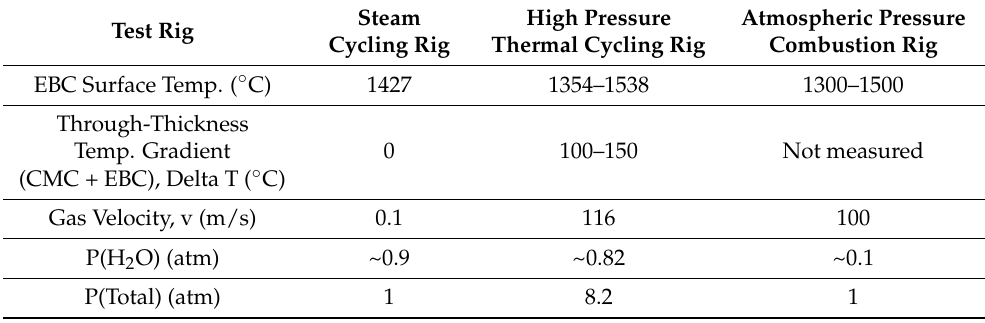
Table 1. Rig Test Parameters.